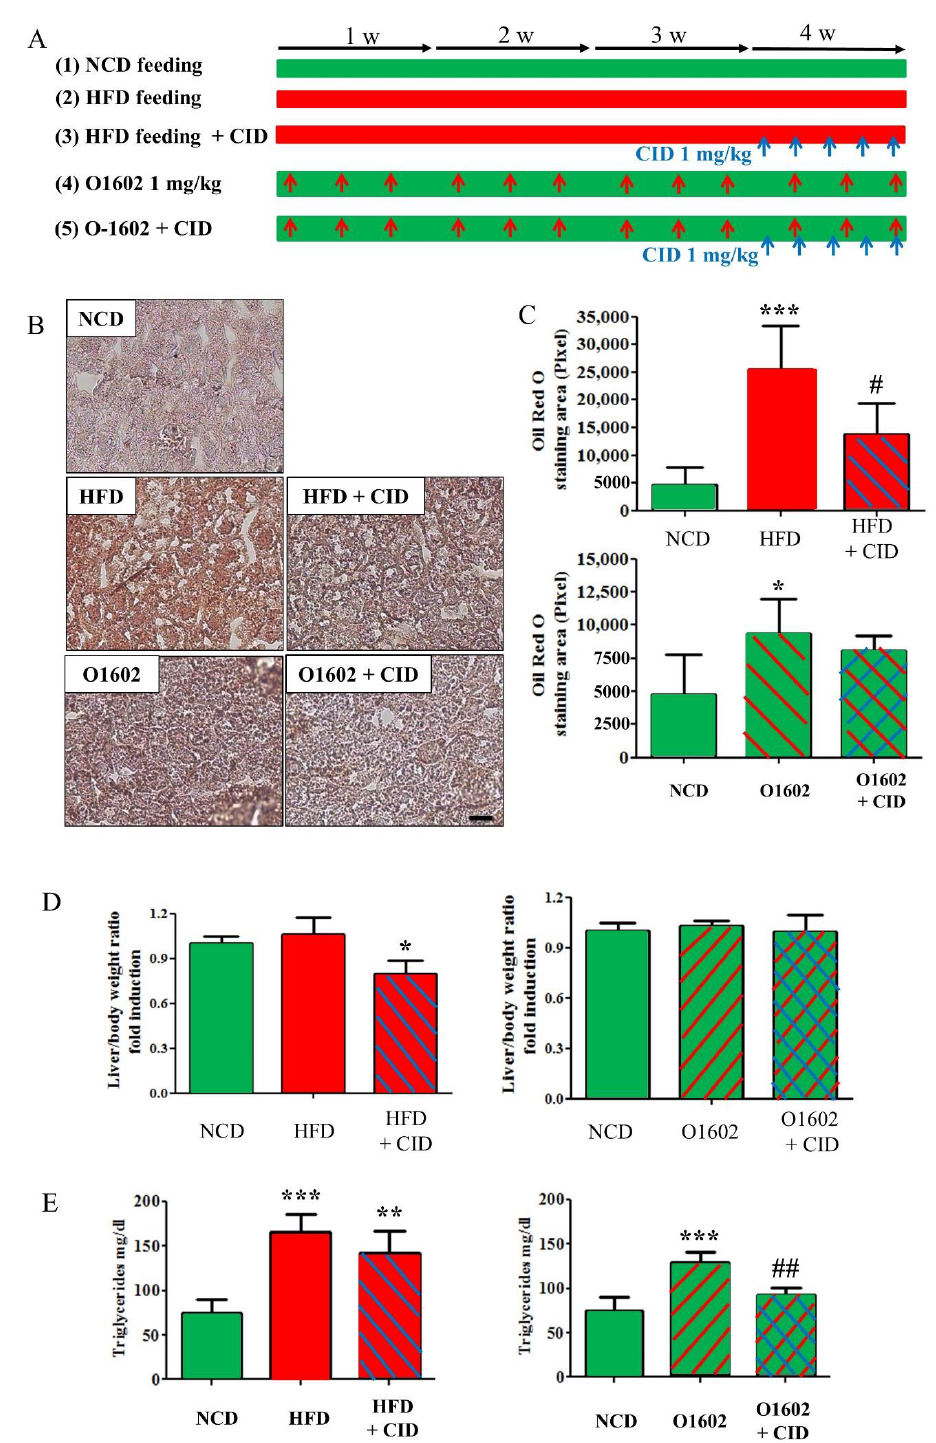
Figure 7. CID16020046 inhibits O-1602-induced triglycerides accumulation in the liver. ( A ) Experimental protocol. HFD was fed to C57BL/6 mice for 4 weeks and O-1602 was administrated by i.p. injection three times per week for 4 weeks. CID16020046 was administrated by i.p. injection five times per week for the last week of 4-week treatment of HFD or O-1602. ( B ) Oil red O staining of liver sections. ( C ) Histograms of oil red O staining. The scale bar means 20 µ m. ( D ) Liver/body weight ratio. ( E ) Triglycerids contents in serum. Green color means NCD, red color for HFD, red hatching or arrows for O-1602 administration, blue hatching or arrows for CID16020046 administration. Results are presented as the means ± SDs of 5 mice per group. * p < 0.05, ** p < 0.01, *** p < 0.001 vs. the NCD group; # p < 0.05, ## p < 0.01, vs. O-1602